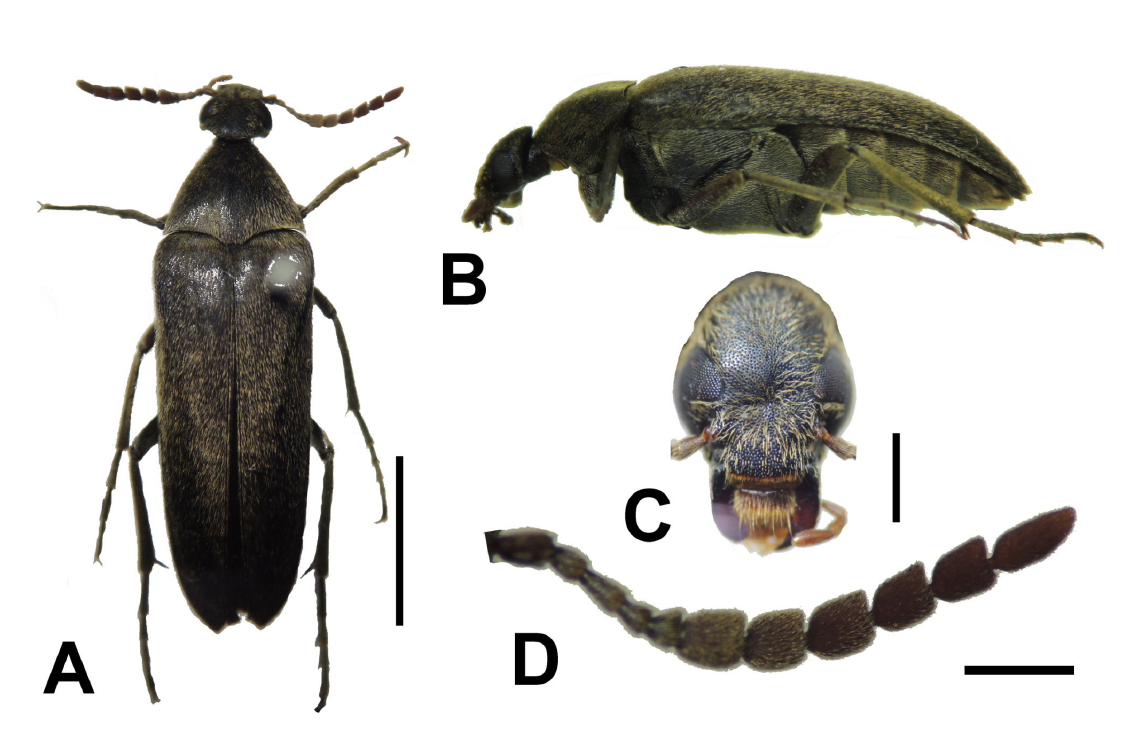
Fig. 5. An extant species of Ptilophorinae, Trigonodera tokejii (Nomura & Nakane, 1959). A . Habitus, dorsal view. B . Habitus, lateral view. C . Head, frontal view. D . Antenna. Scale bars: A–B = 5.0 mm; C–D = 1.0